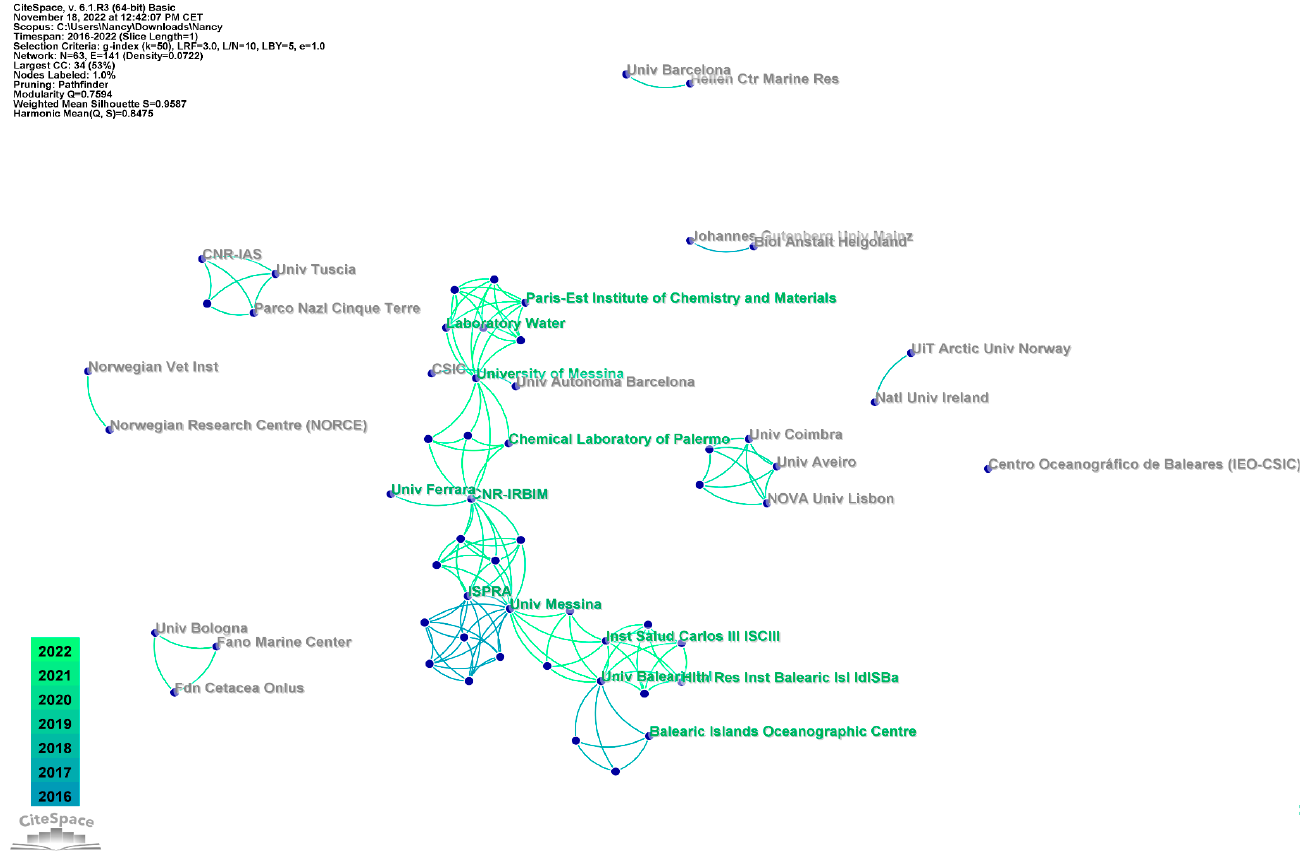
Figure 3. Distribution of organizations based on the number of records attributed to authors based in each organization.